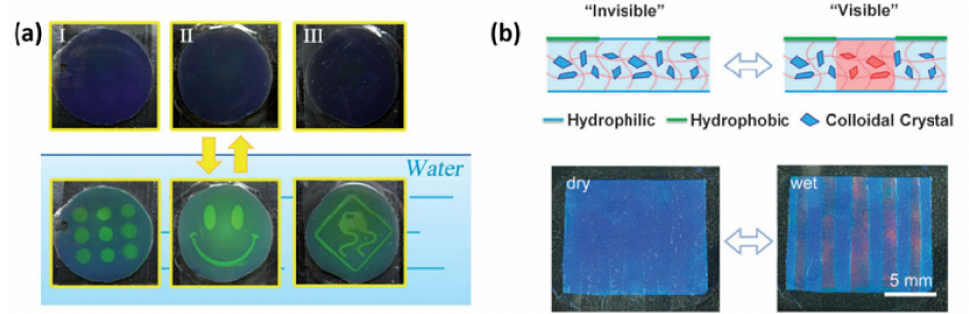
Figure 6. Invisible colloidal PC patterns shown by water. ( a ) The invisible prints prepared by selective cross-linking method revealed by soaking in water for 5 min. Reused with permission from Reference [52], Copyright 2012, The Royal Society of Chemistry. ( b ) The invisible print prepared by selective hydrophobic modification revealed by soaking in water within 10 s. Reused with permission from Reference [49], Copyright 2015, The Royal Society of